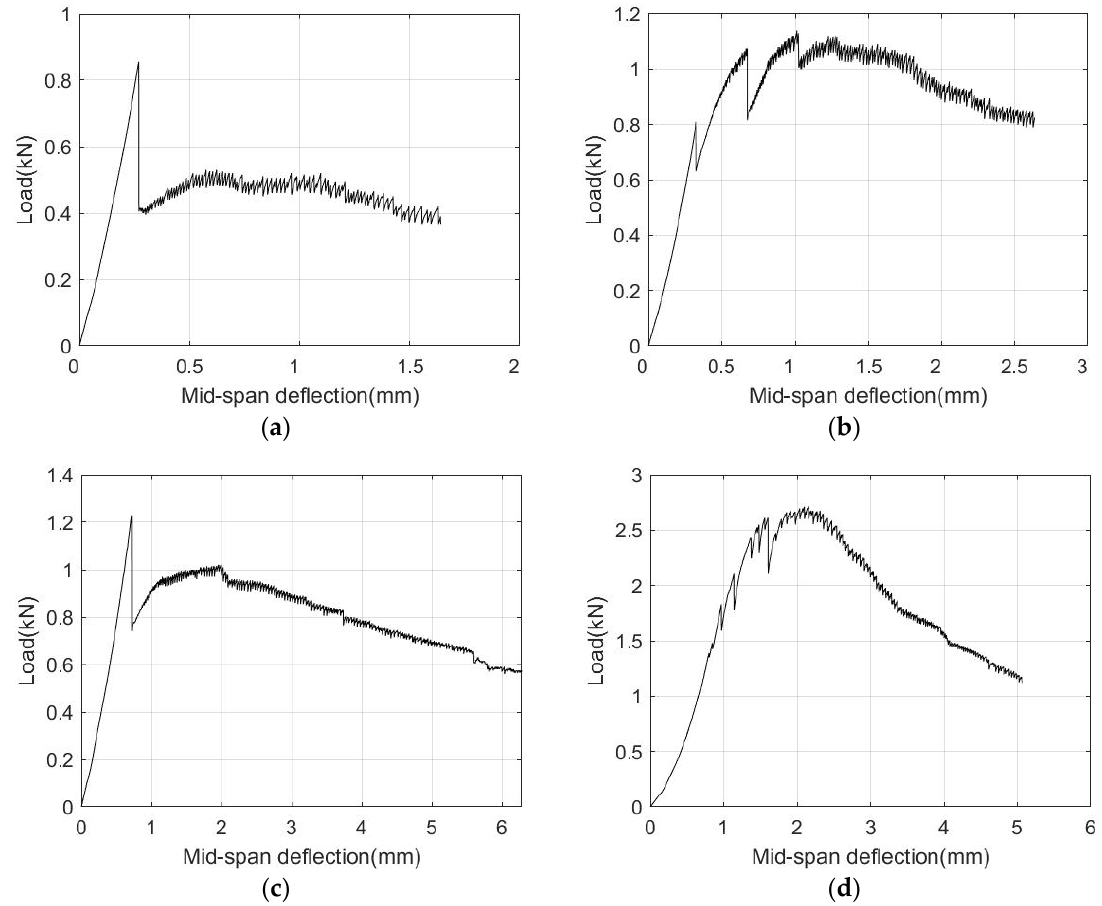
Figure 15. Load–deflection curves for 200 mm × 50 mm × 20 mm UHPFRC beams. ( a ) 1%-15-s6; ( b ) 1%-15-s4; ( c ) 2%-20-s8; and ( d ) 2%-20-s5.